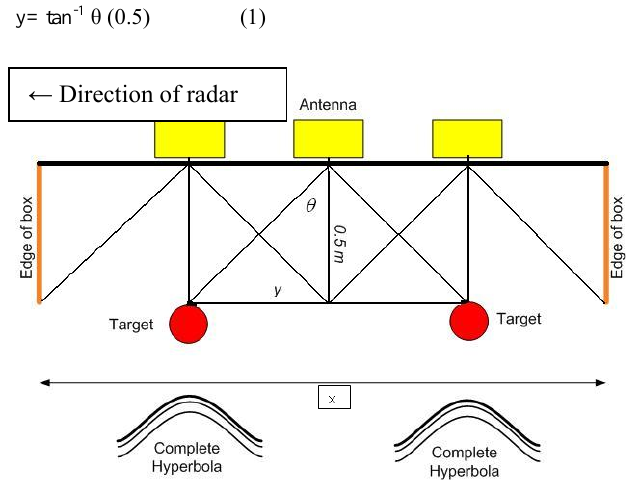
Figure 3: Minimum width of test